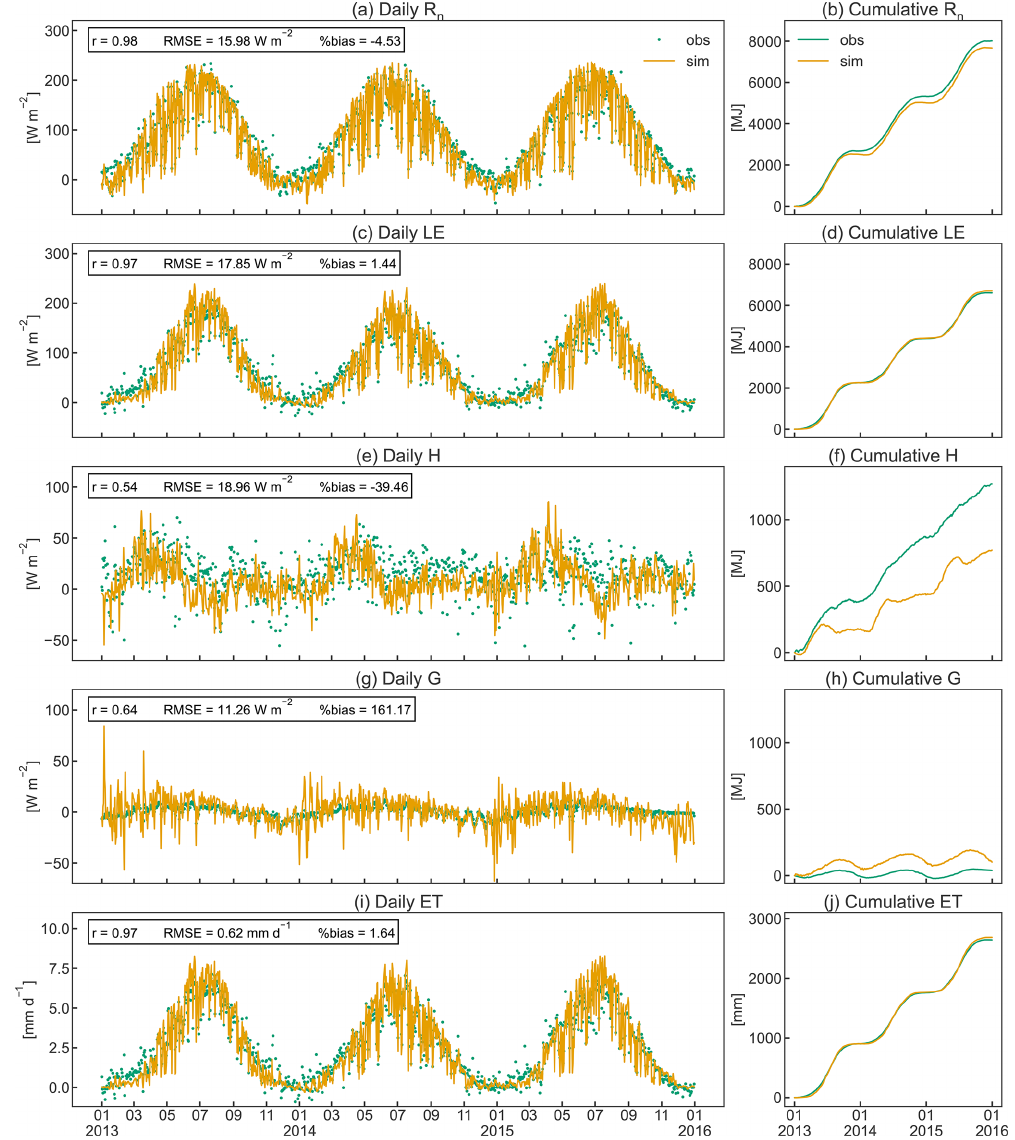
Figure 8. Daily (a, c, e, g, i) and cumulative (b, d, f, h, j) observed and simulated fluxes of net radiation ( R n ), soil heat ( G ), latent heat ( H ), sensible heat (LE), and evapotranspiration (ET) for the studied apple orchard between 2013 and 2015. Pearson’s coefficient of determination ( r ), the root mean square error (RMSE), and the percent bias (%bias) are displayed as statistical